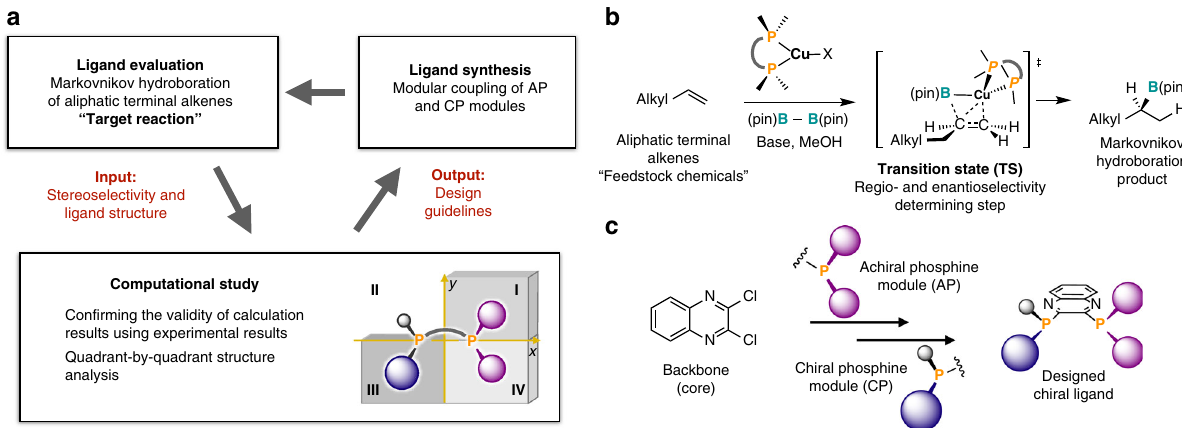
Fig. 1 Ligand-design strategy based on a combination of computational and experimental evaluations. a Iterative chiral-ligand-optimization cycle. b Copper (I)-catalyzed enantioselective Markovnikov hydroboration of aliphatic terminal alkenes. [(pin) = pinacolato] c Modular synthesis of quinoxaline-based P- chirogenic bisphosphine